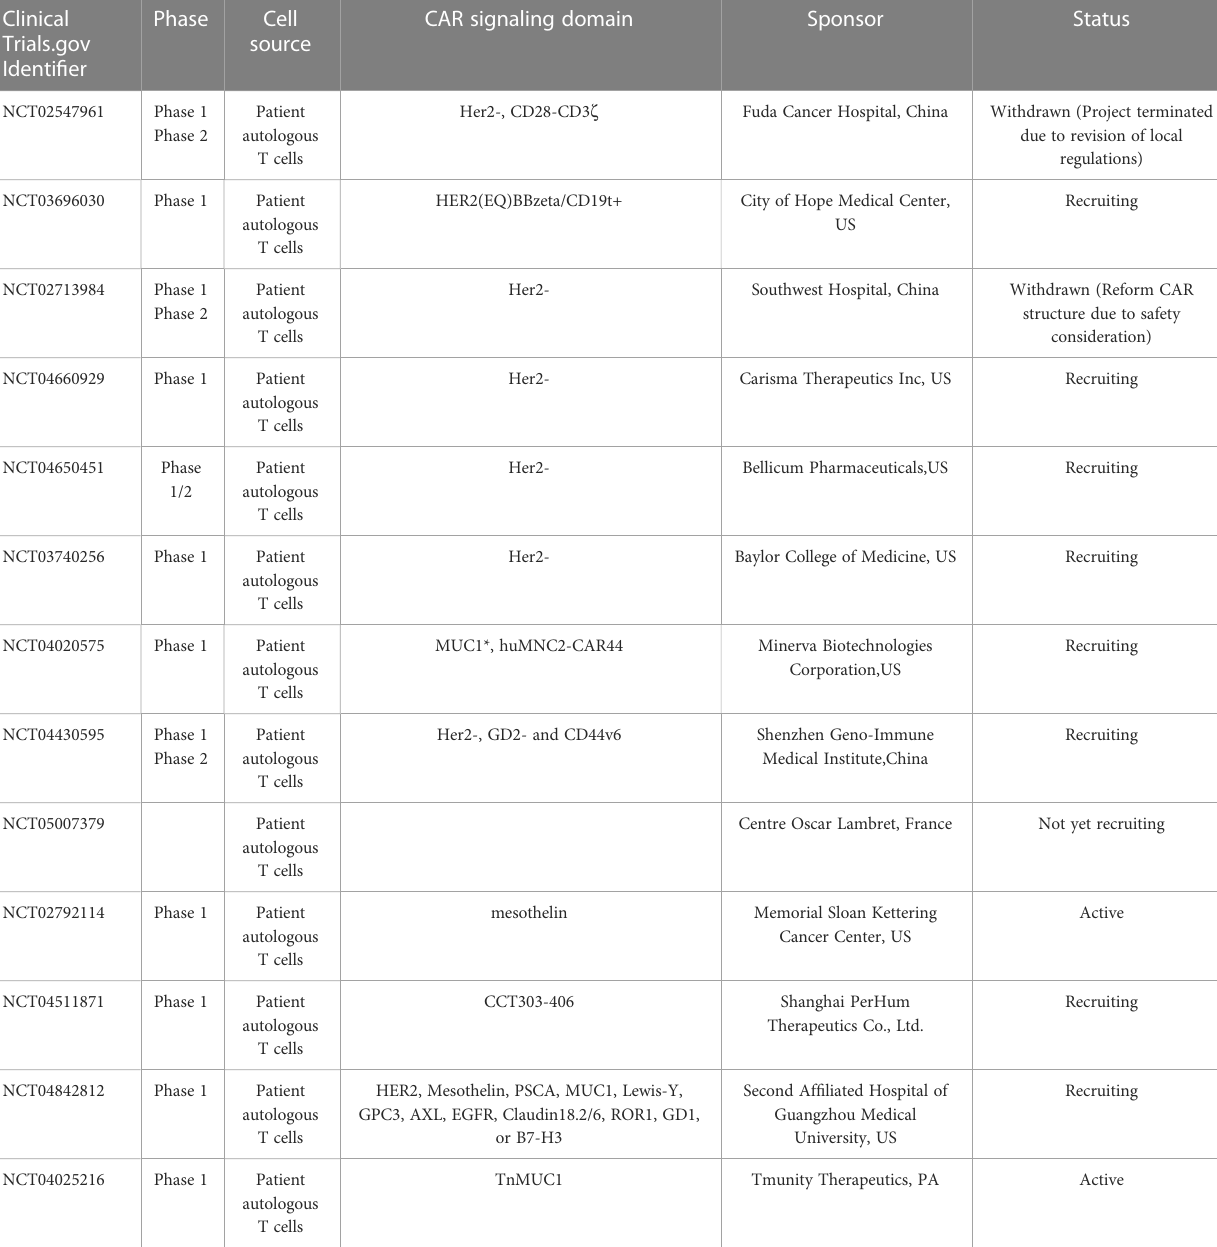
Data obtained from